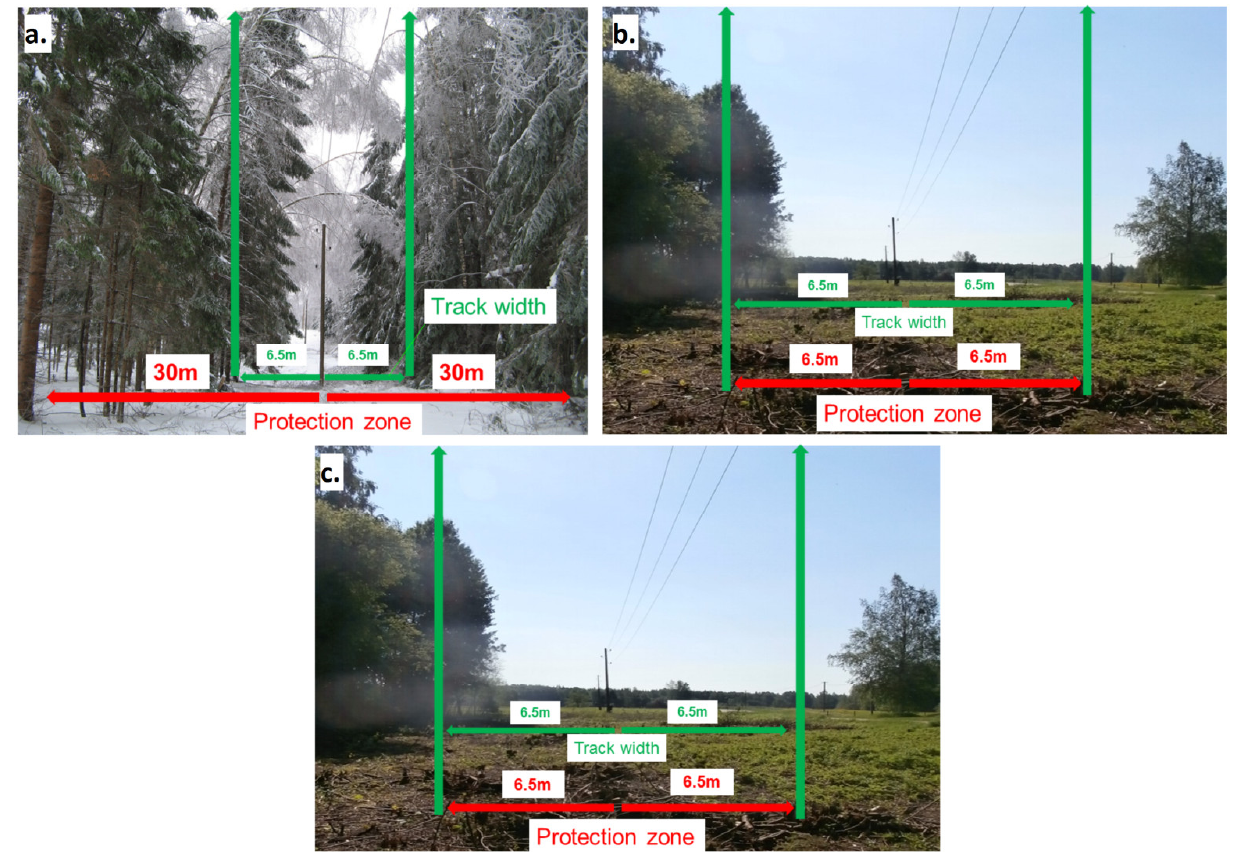
Figure 21. Vegetation cleaning requirement for medium-voltage line: ( a ) forest area; ( b )outside cities and villages; ( c ) cities and villages.